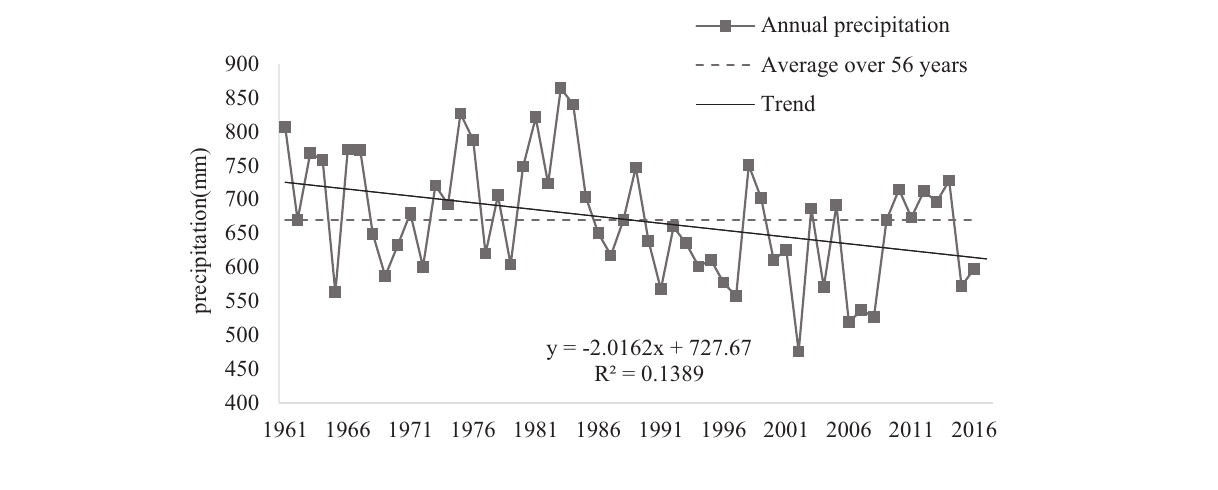
Frontiers in Ecology and Evolution |